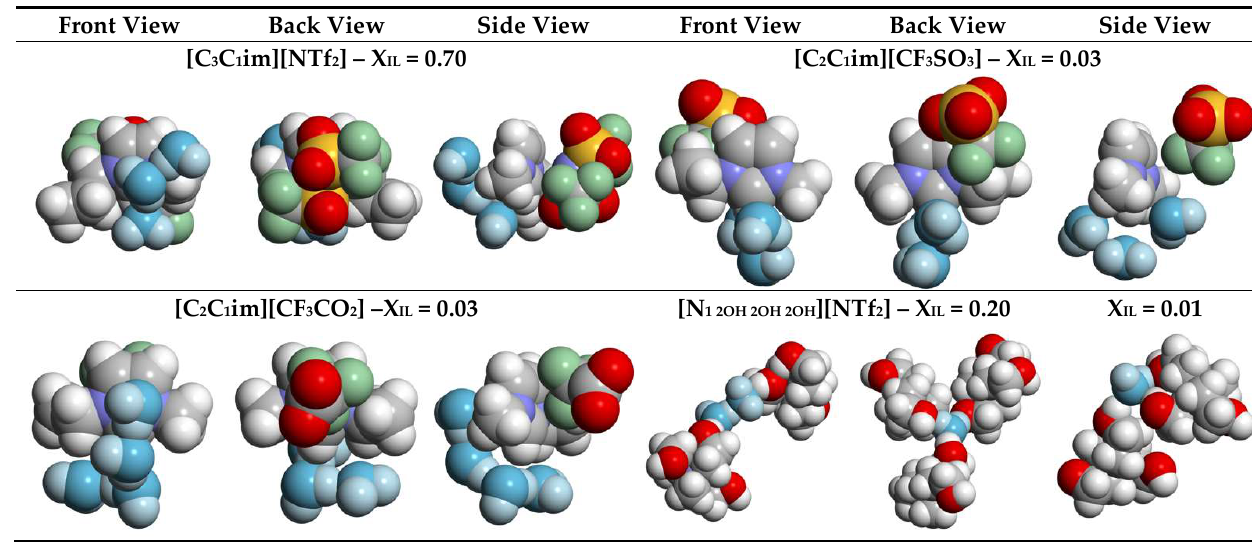
Figure 18. Examples of aggregates and clusters formed by cations, anions, and water molecules cooperating via hydrogen bonding and F- π interactions, found in MD simulation trajectories of the several studied systems. Atoms of cations and anions are depicted in CPK colors and water atoms are represented in blue hues.